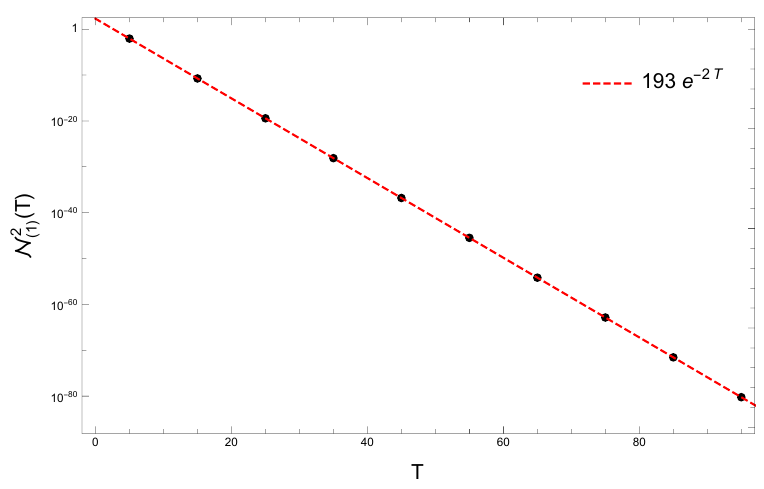
Figure 12 . Plot of N 2 ( T ) in the unwarped limit τ c → 0 . We see that the normalisations fall with (1) T as χe − aT , with χ ≈ 193 and a ≈ 2 . See main text for further